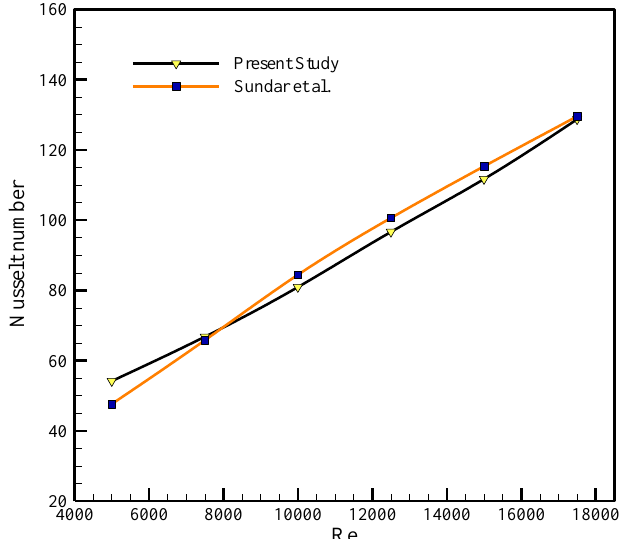
Figure 4. Comparison of calculated Nusselt numbers and those of Sundar et al. [43] study. To validate the hybrid nanofluid modeling through the heat exchanger, the friction factor data from the experimental work of Yarmand et al. [34] were used, and the rough comparison was made between the results of our study and those reported by Yarmand et al. [34] as plotted in Figure 5 at heat flux equal to 600 W/m 2 , L = 1.4 m, D = 0.01 m and 0.1% solid volume fraction. The present study modeling has shown good agreement against the experimental data. The difference between the results could be due to the possible uncertainties of Yarmand et al. [34] study, which did not report on that paper.